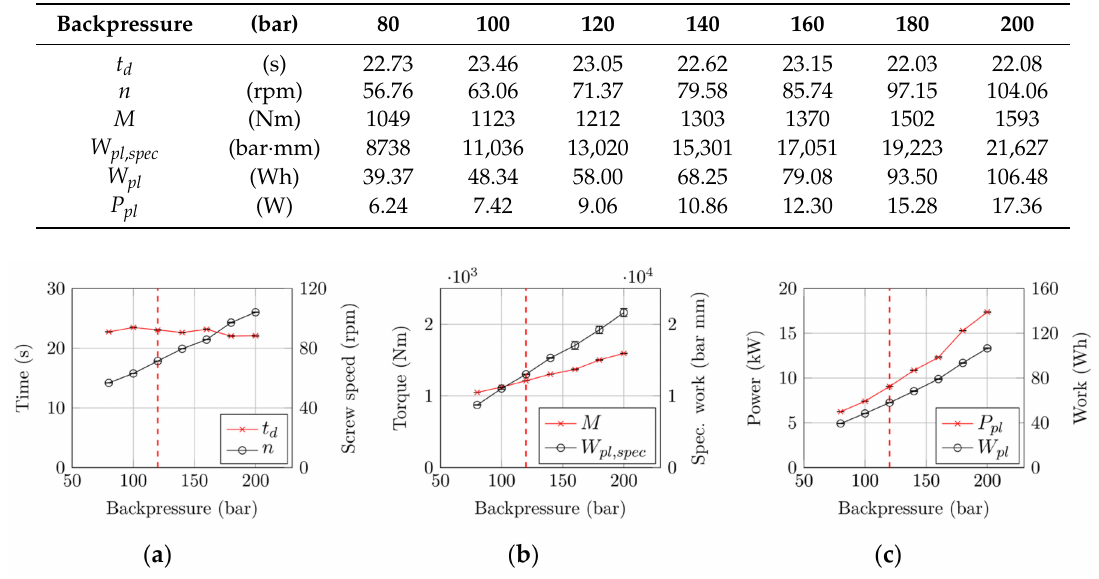
Table 2. Various performance parameters for assessing solubility during backpressure optimization.